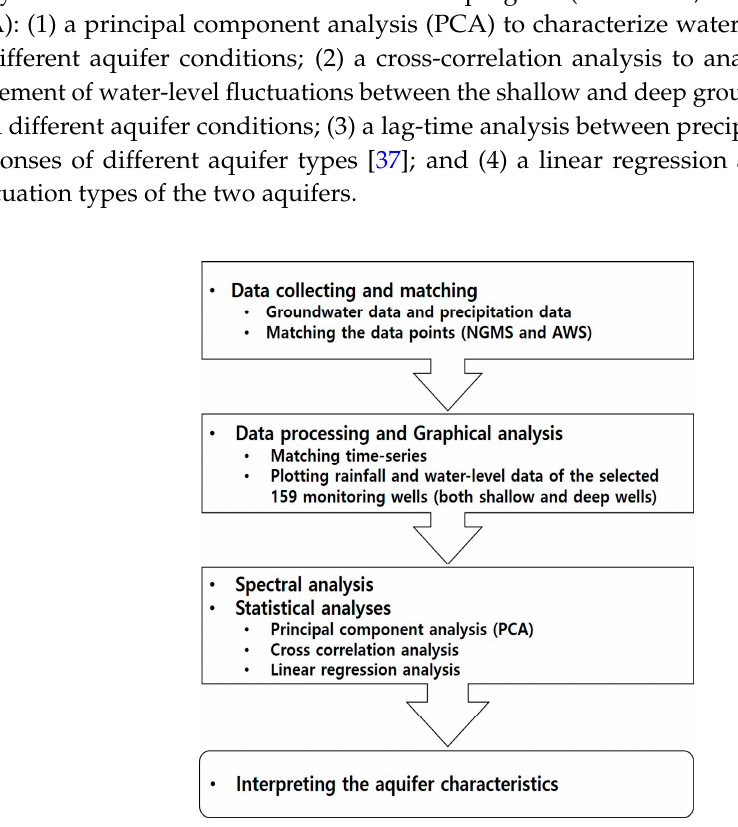
Figure 3. Flow chart of the data analysis process for this study. Table 2. Principal periods by tide effects, type of aquifer, and expected response to various tides (modified from [33,38]).